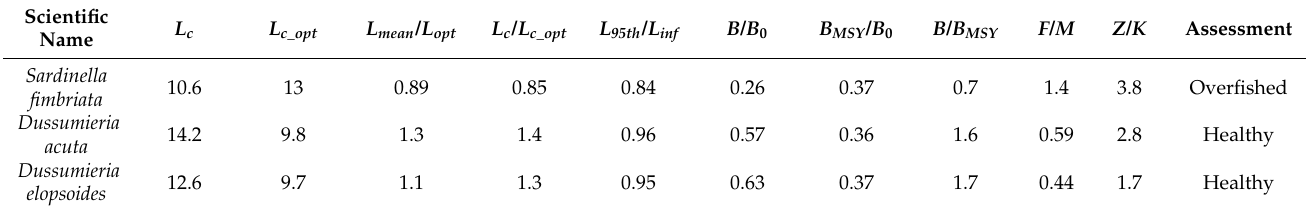
Table 2. Estimated results of three sardine species using length frequency (LF) data by LBB